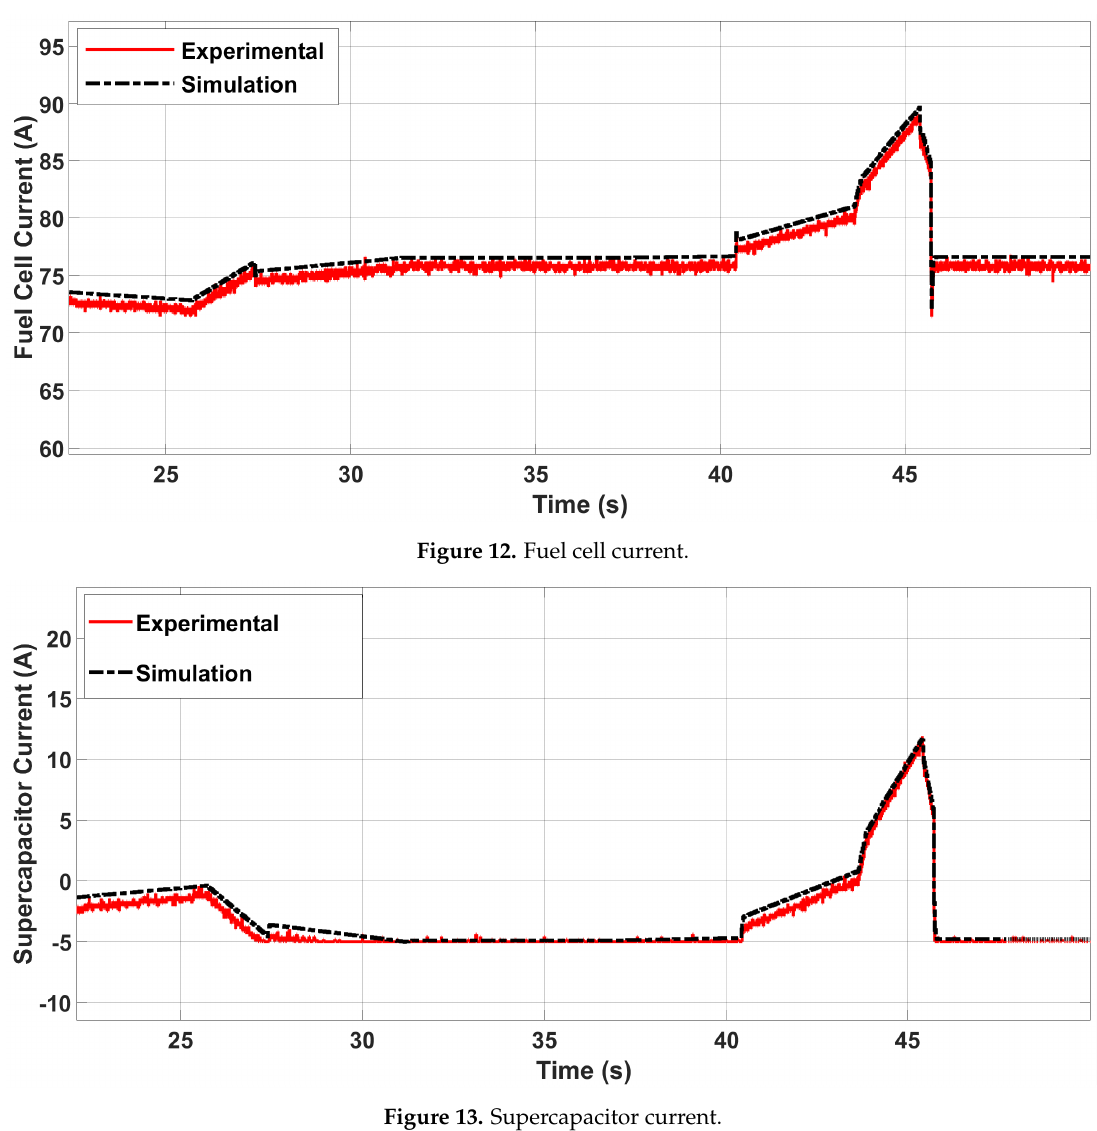
Figure 13. Supercapacitor